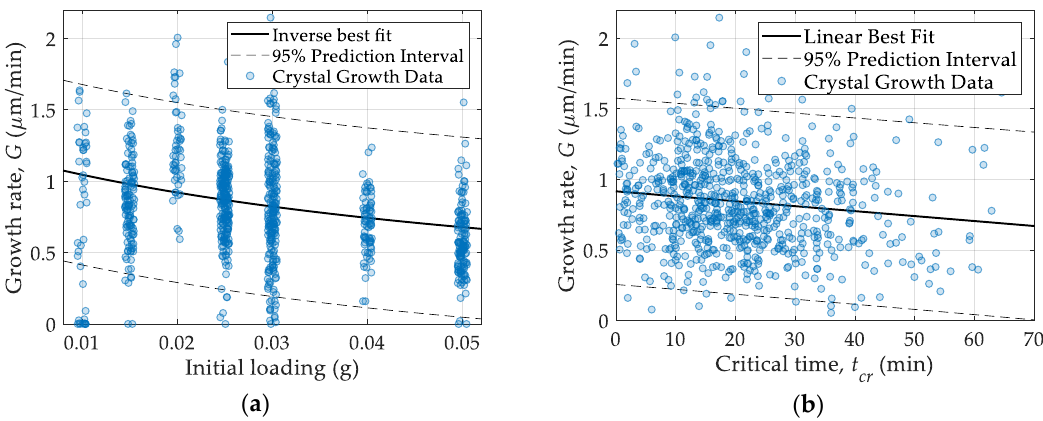
Figure 5. ( a ) Growth rate of individual crystals versus the initial loading of the experiment in which the growth rate was measured, horizontal jitter is introduced to illustrate the density of data points. ( b ) Growth rate of individual crystals versus the critical time of the crystal. The solid lines are the linear best fits and the dashed curves are the 95% prediction intervals.